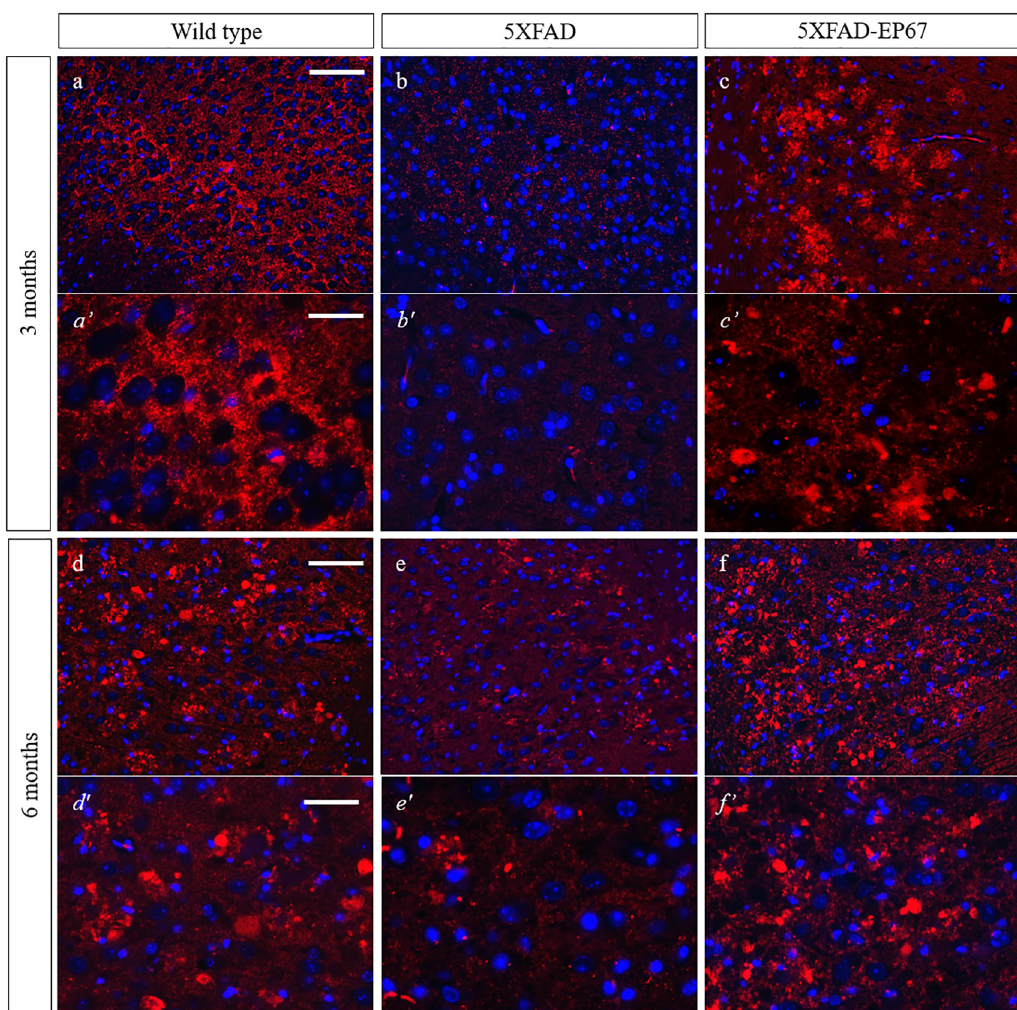
Fig 7. Synaptophysin expression. Representative sagittal cortex sections from 3 and 6 month old wild type (a, a’ & d, d’ ), 5XFAD (b, b’ & e, e’ ) and 5XFAD EP67 treated (c, c’ & f, f’ ) mice sections were co-stained with an antibody against Synaptophysin (-red- excitation λ : 358 emission λ :461) and DAPI nuclear staining (-blue- excitation λ : 555 emission λ :580). Scale bars: a-c & d-f 150 μ m, a’- c’ 75 μ m and d’-f’ 48 μ m.